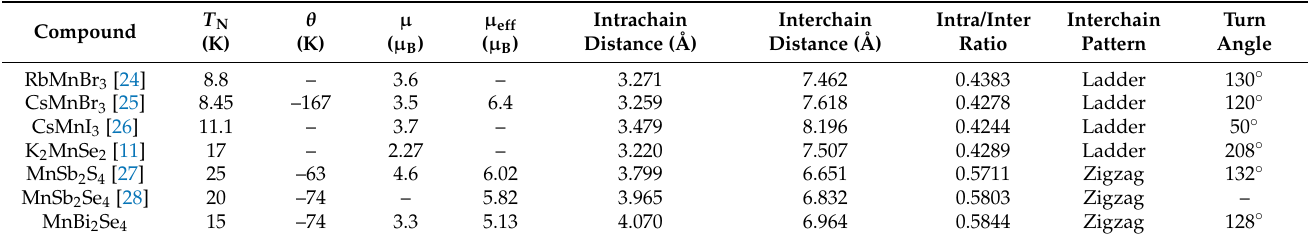
Table 2. Properties and Magnetic-Chain Halides and